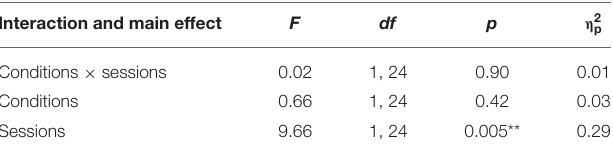
TABLE 1 | Results of ANOVA for RTs. TABLE 2 | Results of ANOVA for hit